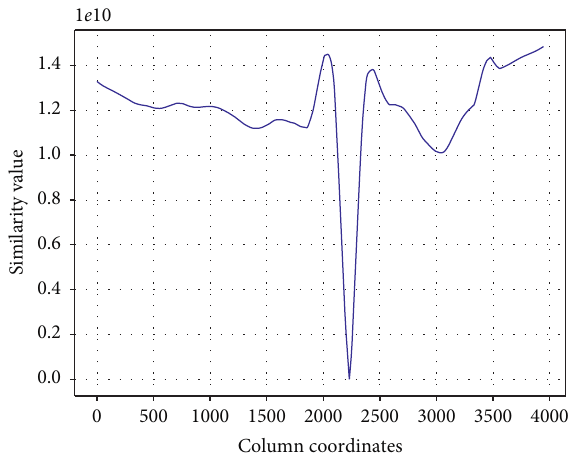
Figure 8: RAM. (a) The RAM segmented from the original image. (b) The RAM after image